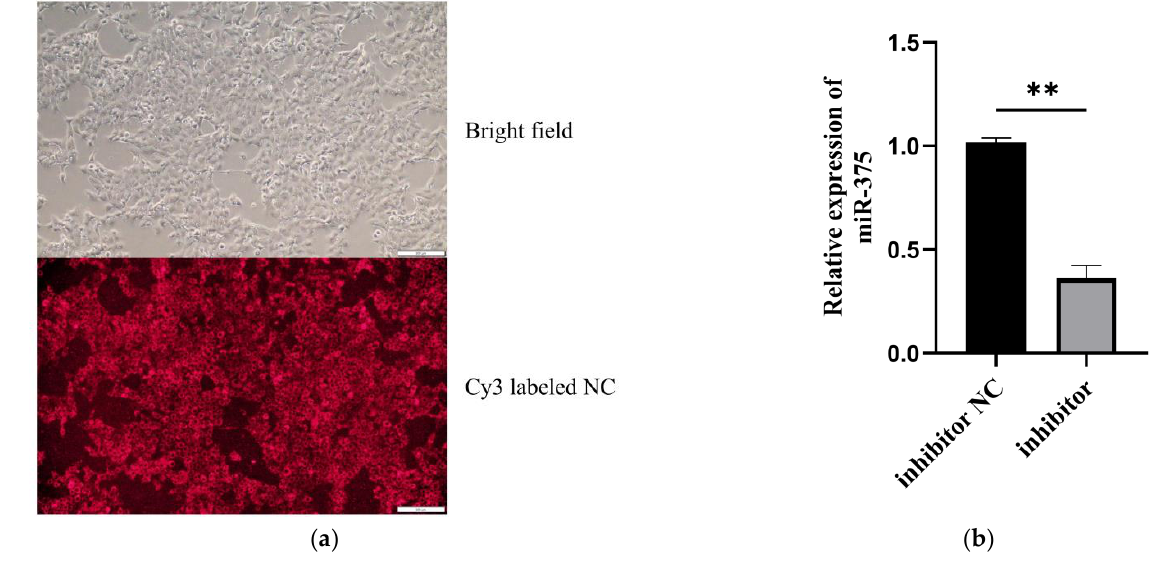
Figure 1. The miR-375 silencing efficiency in MAC-T. ( a ) Cy3-labeled inhibitor NC transfected into the cells detected using an inverted fluorescence microscope. ( b ) Analysis of miR-375 silencing efficiency in MAC-T using qPCR, ** p < 0.01.